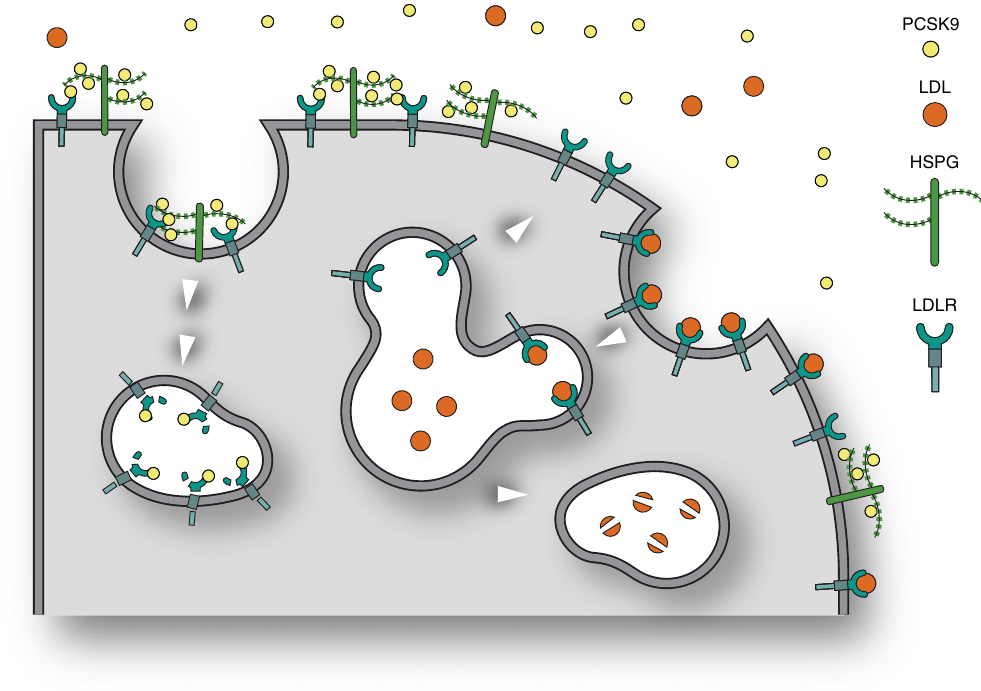
Fig. 8 Model depicting the role of HSPG in PCSK9 activity in the hepatocyte. The model shows a hepatocyte and how LDLR in the absence of PCSK9 mediates endocytosis of bound LDL cholesterol particles followed by lysosomal degradation of LDL, while LDLR recycles to the cell surface. HSPG mediates the capture of PCSK9 and its subsequent presentation to LDLR thereby directing LDLR itself to lysosomes for degradation. In the model, we have depicted HSPG as syndecan but based on the present data we cannot exclude that it may also be a